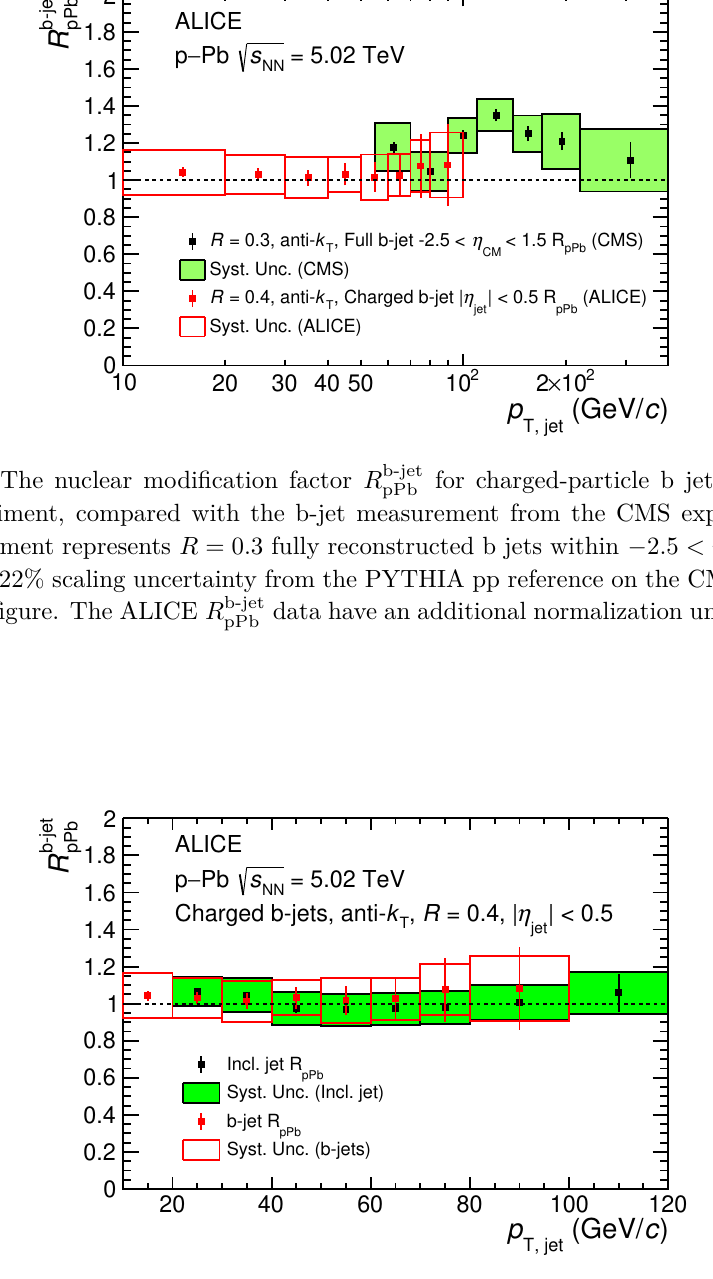
data from luminosity pPb